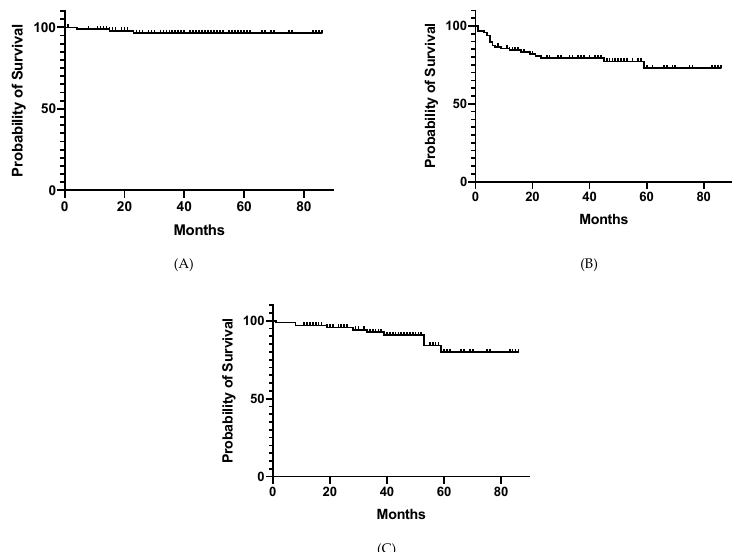
Figure 1. Clinical outcomes after neoadjuvant radiotherapy. Cumulative rates of local control, relapse-free survival, and over- all survival are shown in A, B, and C, respectively. The ROC curve indicated cut-off values of 0.053, 3.4, and 1.83 for C-reactive-protein- to-albumin ratio (CAR), carcinoembryonic antigen (CEA), and neutrophil-to-lymphocyte ratio (NLR), respectively (Supplemental Figure S1). Univariate analyses revealed that the following factors were significantly associated with poor OS: no concurrent administra- tion of capecitabine, high CAR, high CEA level, and high NLR (Table 5, Figure 2). Multi- variate analysis indicated that high NLR was independently associated with poor OS. Table 5. Univariate and multivariate analyses for the factors associated with overall survival. Univariate Analysis